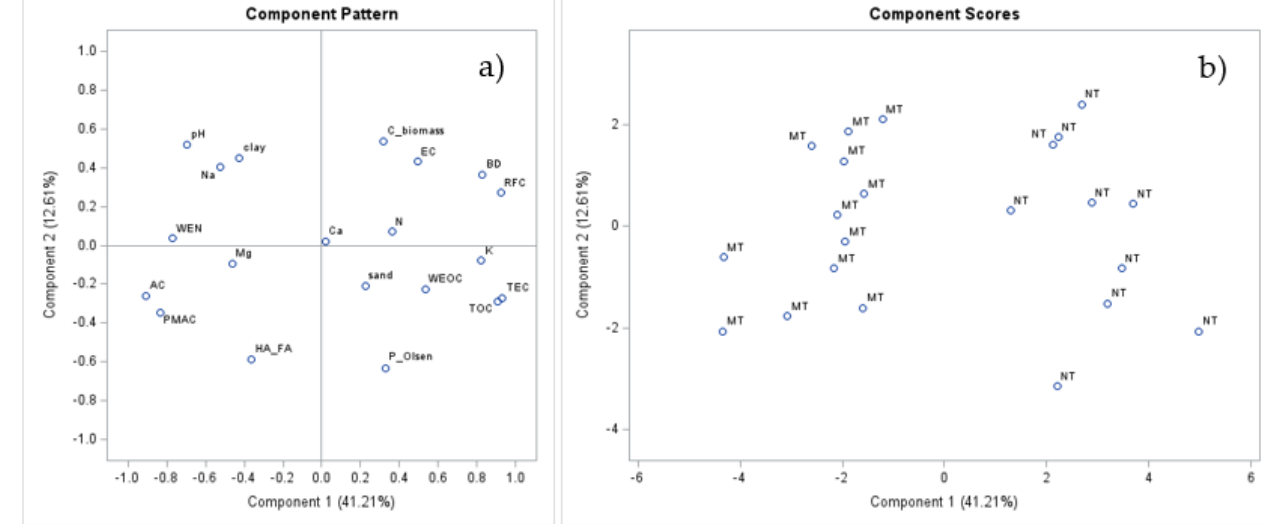
Figure 2. Plots of the component loadings ( a ) and scores ( b ) of the first two principal components extracted in the analysis carried out on the whole set of soil indicators. Variance explained: PC1 = 41.21%; PC2 = 12.61%. MT = minimum tillage; NT = no-tillage. WEOC = water extractable organic carbon; WEN = water extractable nitrogen; C_biomass = microbial biomass carbon; TOC = total organic carbon; TEC = alkali-extractable carbon; HA_FA = humic and fulvic acid carbon; N = total nitrogen; P_Olsen = Olsen available phosphorus; EC = electrical conductivity; Ca 2+ , Mg 2+ , Na + , K + = exchangeable cations. BD = dry bulk density; P MAC = macroporosity; AC = air capacity; RFC = relative field capacity.